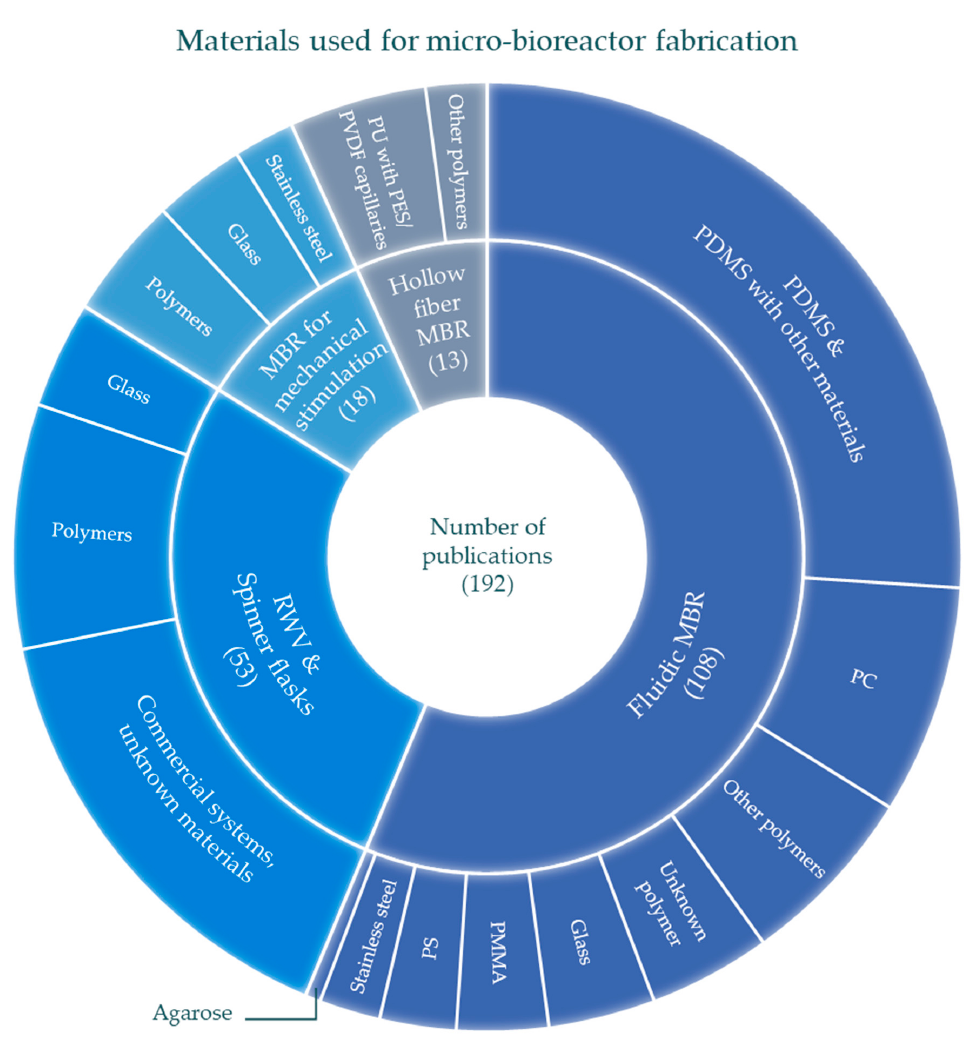
Figure 5. Distribution of studies in the period from 2000 to 2020 with regard to the materials used for MBR fabrication. The materials used for the most common types of MBR, namely fluidic MBR, RWVs and spinner flasks, MBR for mechanical stimulation and hollow fiber MBR. Abbreviations: PDMS (polydimethylsiloxane), PC (polycarbonate), PMMA (Poly(methylmethacrylate)), PS (Polystyrene), PU (polyurethane), PES (polyethersulfone), PVDF (polyvinylidene fluoride); “other polymers” include the publications with the less frequently applied materials stereolithography resin, polyethylene terephthalate, polylactic acid, polytetrafluoroethylene, PU (individually), polyethylene, polyoxymethylene, polypropylene, polyether ether ketone; the category “unknown materials” includes publications in which the applied MBR materials were not further specified. As described earlier, parameters of the 3D microenvironment, such as gradients of signaling molecules, cell/cell ‐ and cell/ECM ‐ interactions, determine the cellular behavior in vitro . Hence, in order to induce or maintain tissue specific cell differentiation and functions, various cell culture